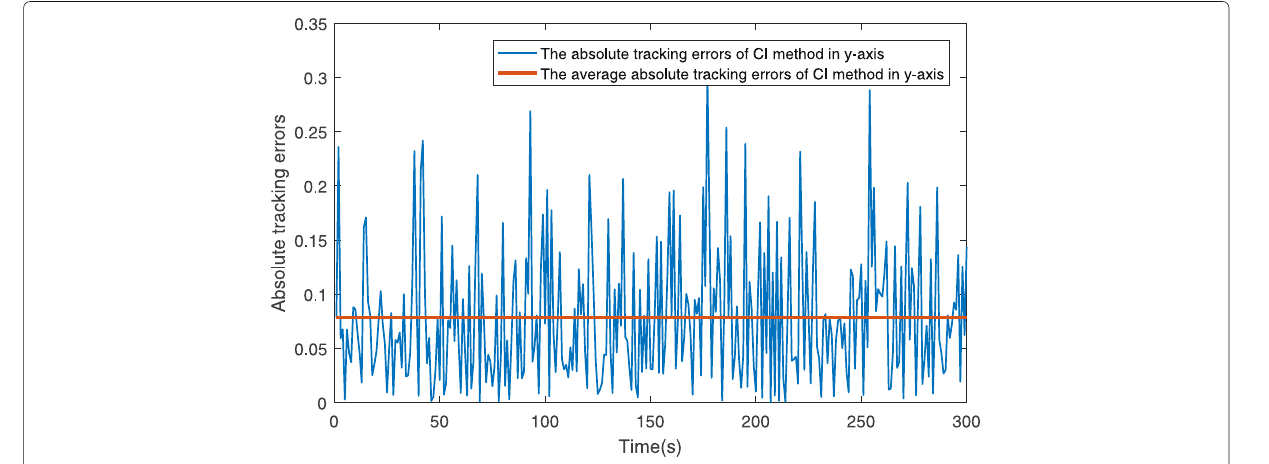
Fig. 16 The absolute tracking errors in of CI method in y -axis with a i = 14